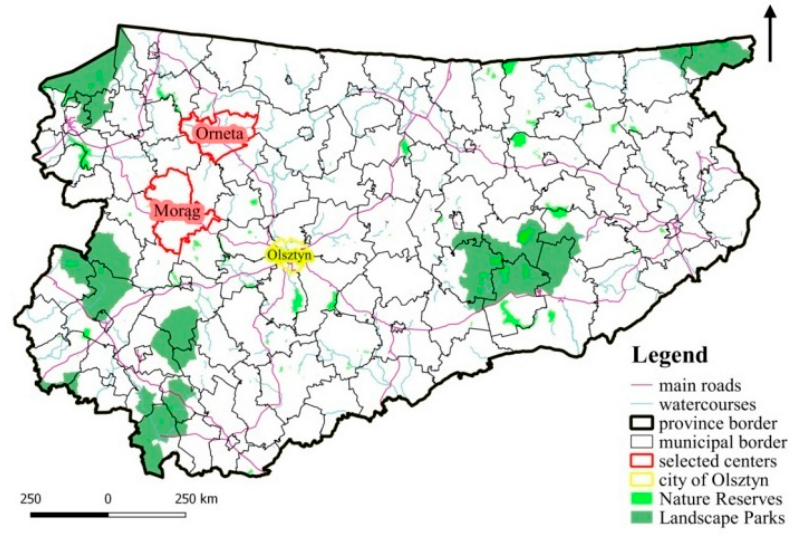
Figure 1. Location of the analyzed towns. Source: own elaboration .